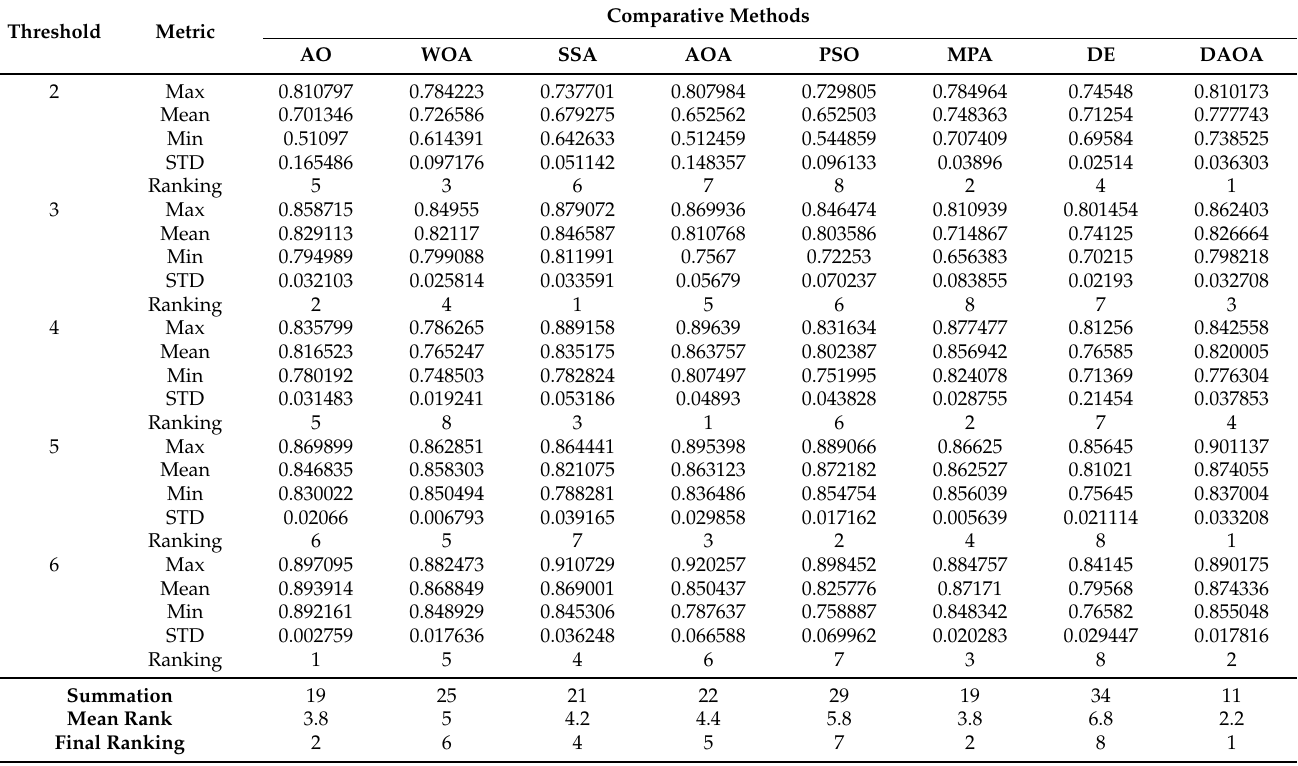
Table 8. The PSNR results of the test case